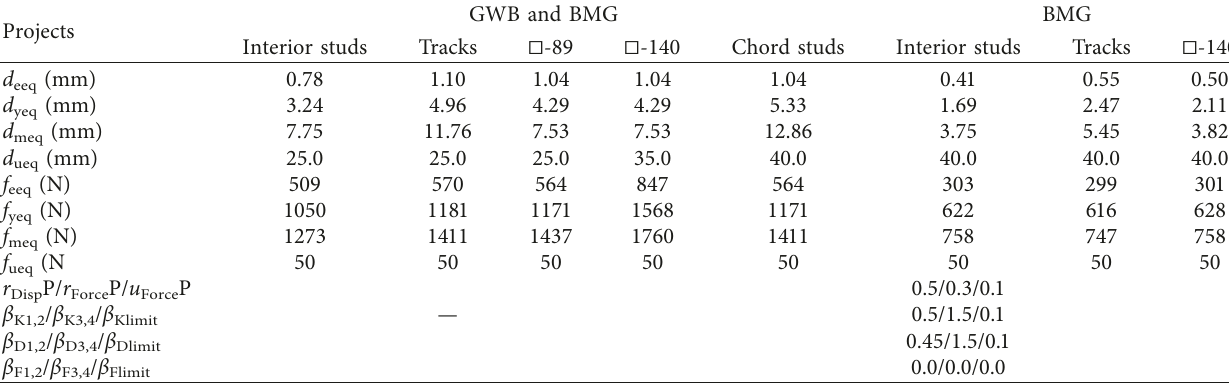
Table 3: Input parameters of